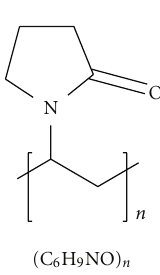
Figure 1: Molecular structure of polyvinylpyrrolidone